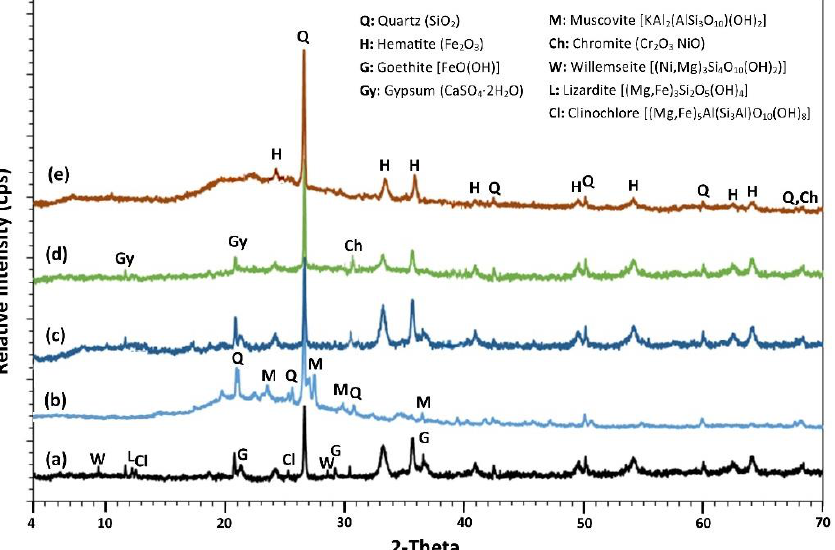
Figure 7. XRD patterns of ( a ) laterite leaching residues, ( b ) metakaolin, and ( c ) AAMs produced using only leaching residues (LR2 AAM) as well as by mixing ( d ) leaching residues and metakaolin at mass ratio 90:10 (LR90MK10) and ( e ) LR90MK10 after firing at 800 °C for 2h. After alkali activation (LR2 AAM), which, as explained earlier in this paper, is poor